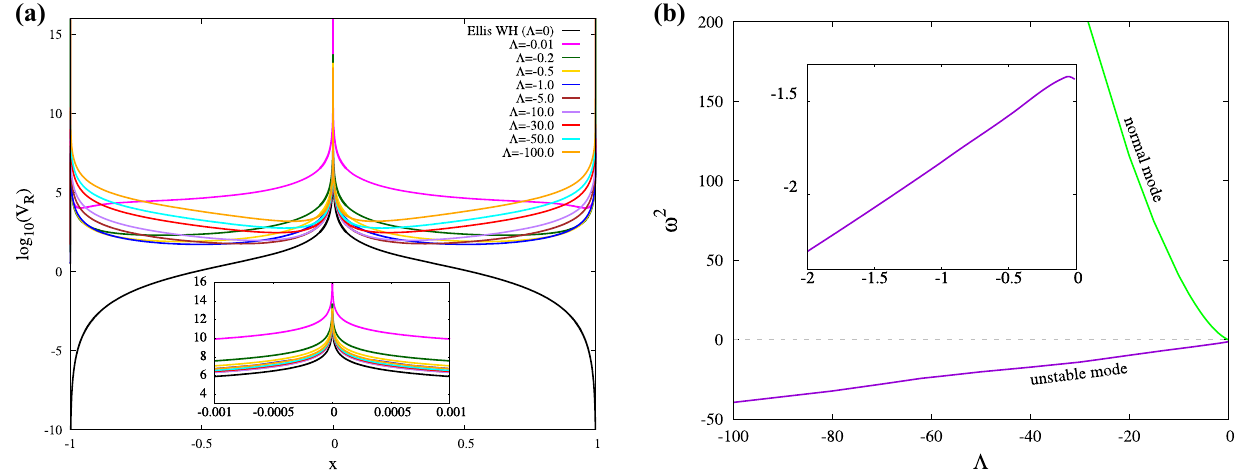
Fig. 4 a Radial effective potential V R vs. compactified radial coordinate x for several values of (cid:3) ; b eigenvalue ω 2 of the unstable mode vs.